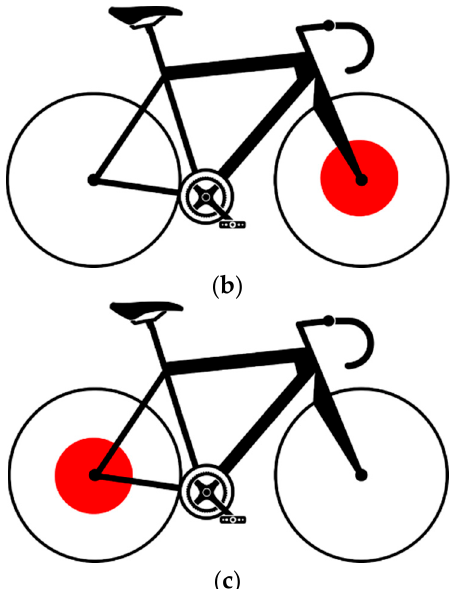
Figure 1. Mid-drive powertrain and hub-type powertrain. The location of assistance motors indicating where motors power is applied is shown in red. ( a ) Mid-drive propulsion—motor transfers power directly to the drivetrain; ( b ) front hub propulsion—motor is placed to spin the front tire; and ( c ) rear hub propulsion—motor is placed to spin the back tire.